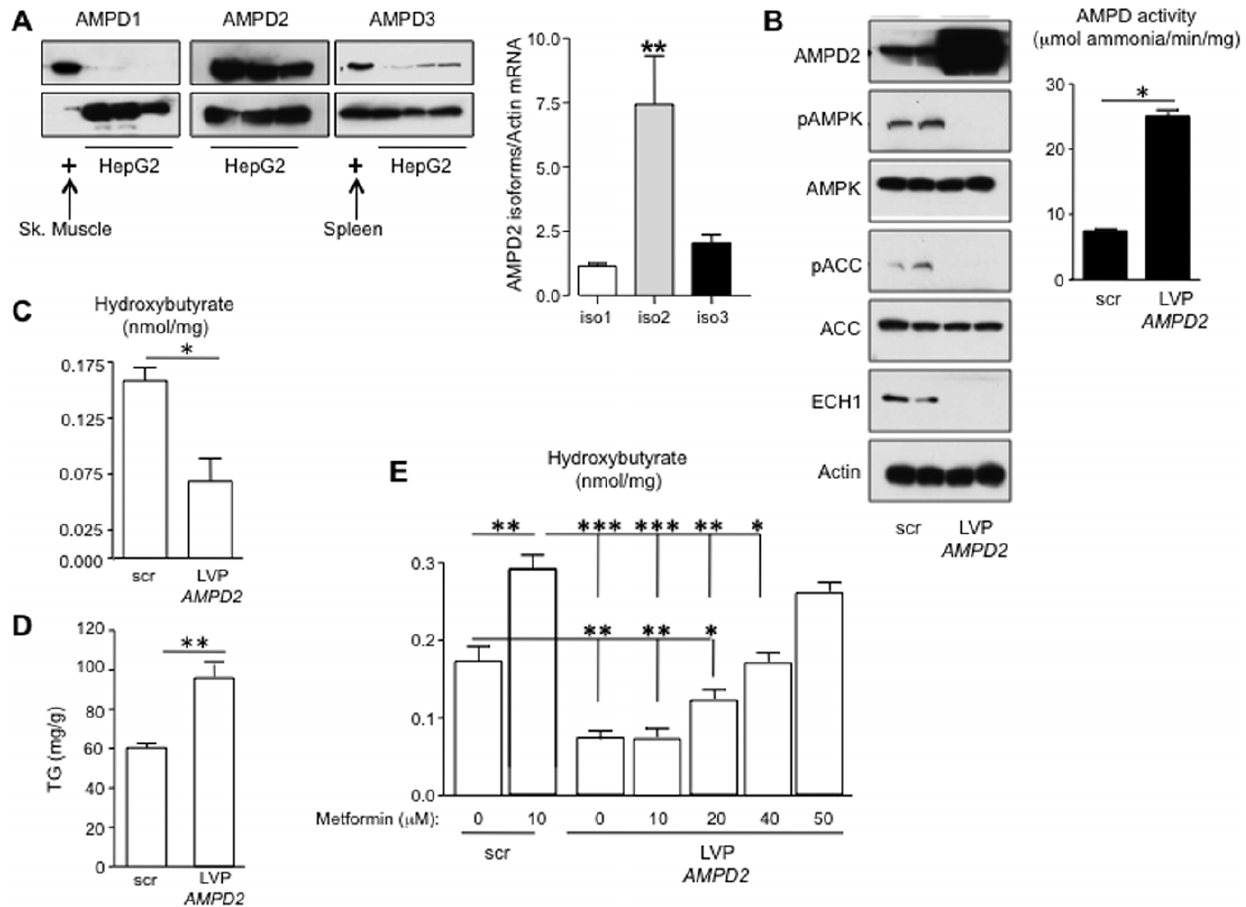
Figure 3. Metformin regulates AMPD2 activity in human hepatocytes. A) AMPD2 is the main isoform in HepG2 cells. The expression of AMPD1 and AMPD3 isoforms is minimal compred to AMPD2. Skeletal muscle and spleen are positive controls for AMPD1 and AMPD3 expression, respectively. Quantitative PCR analysis (bottom) demonstrates that isoform 2 is the predominant isoform of AMPD2. **p , 0.01 versus isoforms 1 and 3. B) Over-expression of AMPD2 down-regulates the activation of AMPK. Transduction of HepG2 cells with lentiviral particles codifying for the isoform 2 of AMPD2 results in significantly higher levels of AMPD2 protein expression as well as AMPD activity. This is paralleled with reduced levels Thr172 pAMPK expression as well as of their target genes ECH1 and Ser79 pACC. *p , 0.05 C–D) Reduction in ECH1 expression in over-expressing AMPD2 hepatocytes is accompanied with lower intracellular b -hydroxybutyrate and higher TG levels. *p , 0.05, **p , 0.01 E) Over-expression of AMPD2 impairs metformin-induced fat oxidation. Metformin 10 m M significantly increased b - hydroxybutyrate levels in cells transducted with scramble RNA. In contrast, no significant change was observed with 10 m M metformin in cells overexpressing AMPD2. Metformin 50 m M significantly increased b - hydroxybutyrate to levels observed in scramble transducted cells *p , 0.05, **p , 0.01, ***p ,